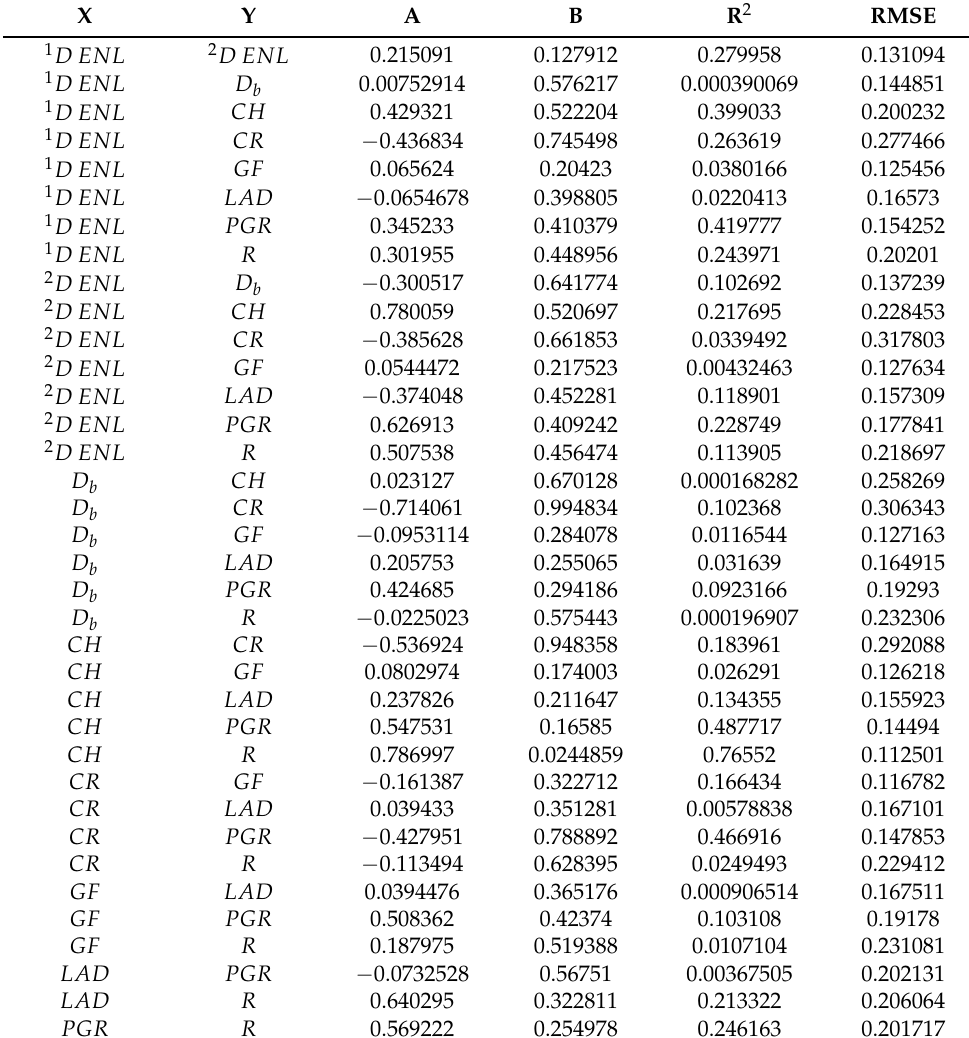
Table A3. Overview of ULS linear regression at 0.5 m grid